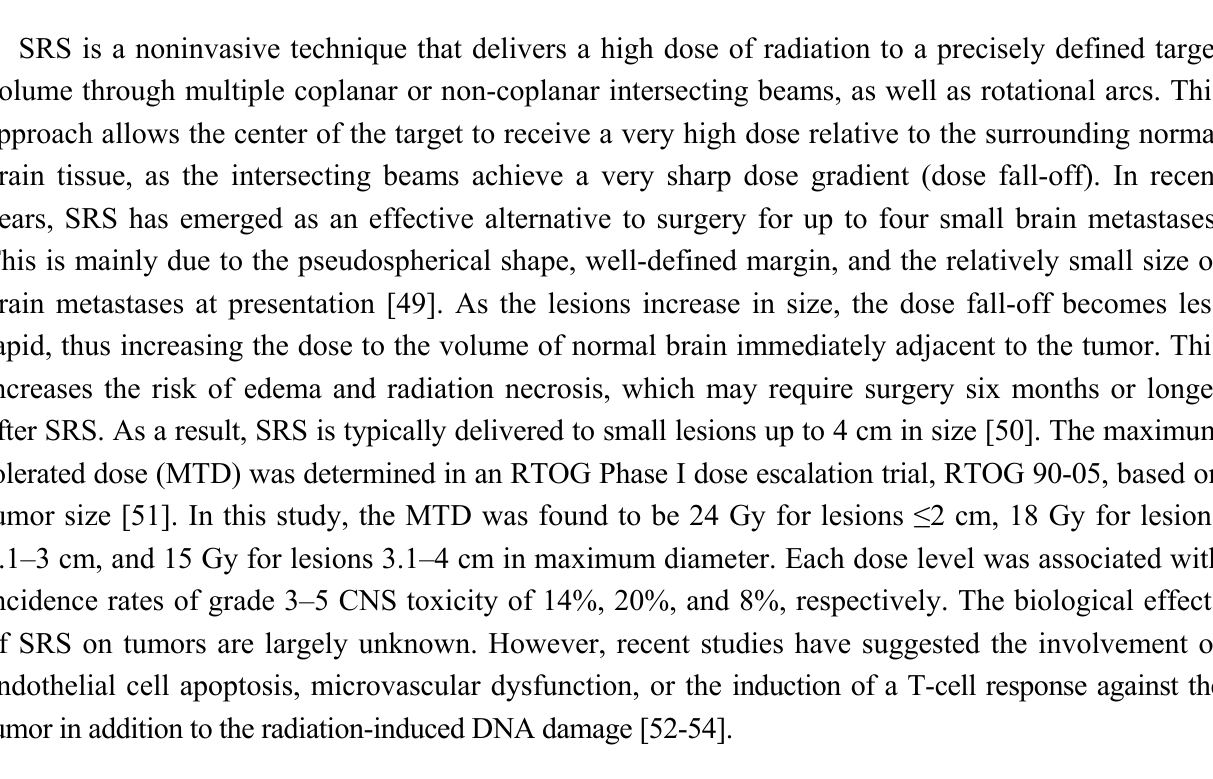
Table 4. Stereotactic radiosurgery (SRS) alone for brain metastasis from lung cancer.